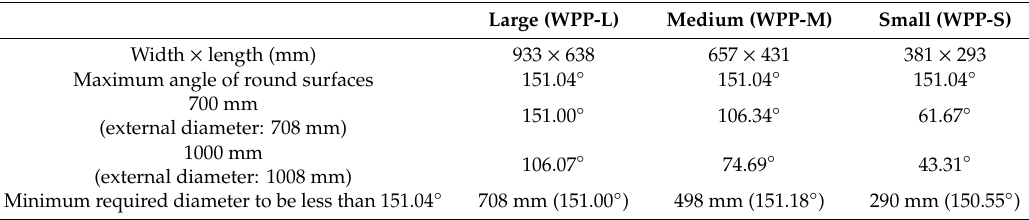
Table 5. Round surface attachable angle calculation.